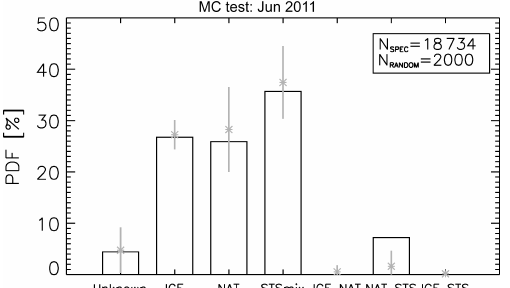
Figure 10. Probability distribution of the Bayesian classifier ap- plied to the MIPAS spectra in the SH polar region in June 2011. Superimposed in grey are the mean value (stars) and standard devi- ation (error bars) of a Monte Carlo simulation varying the PSC type probability matrix (see text for details). The analysis considers only spectra at tangent heights between 16 and 28km and up to 6km below the